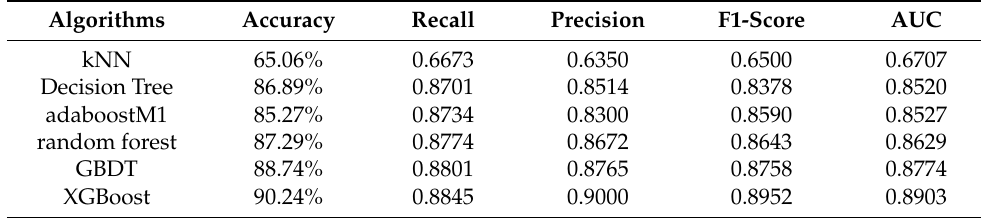
Table 2. Overall result performance of all algorithms (51 features).